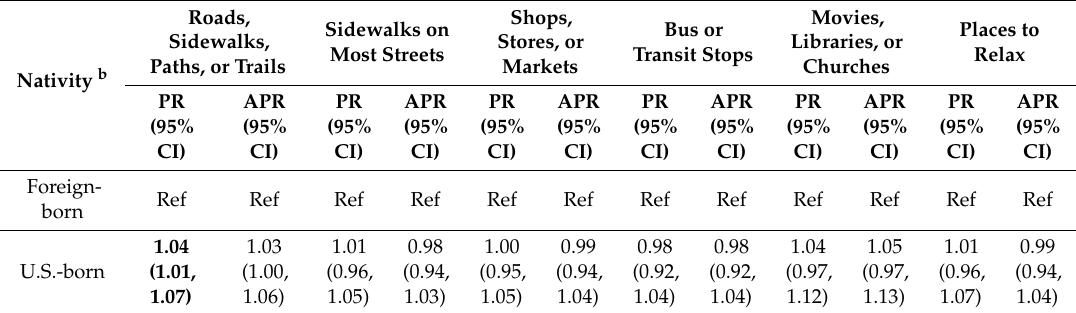
Table 2. Unadjusted and adjusted a prevalence ratios for perceived neighborhood environment attributes among Latinos by nativity, the NHIS